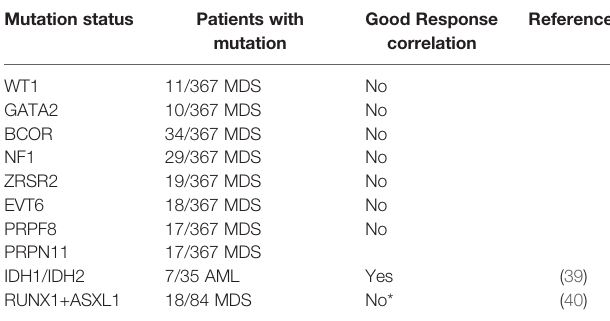
TABLE 1 | Gene mutation and HMA